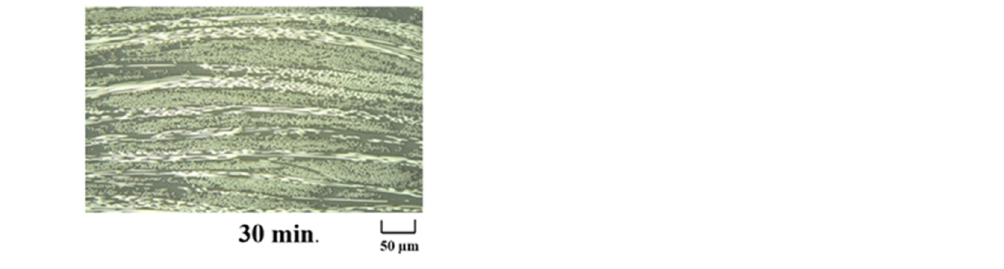
Figure 14. Cross-sectional photographs of composite materials made at molding time is 30 min under molding pressure is 10 MPa. Figure 13. Cross-sectional photographs of composite materials made at different molding times un- der molding pressure is 5 MPa.